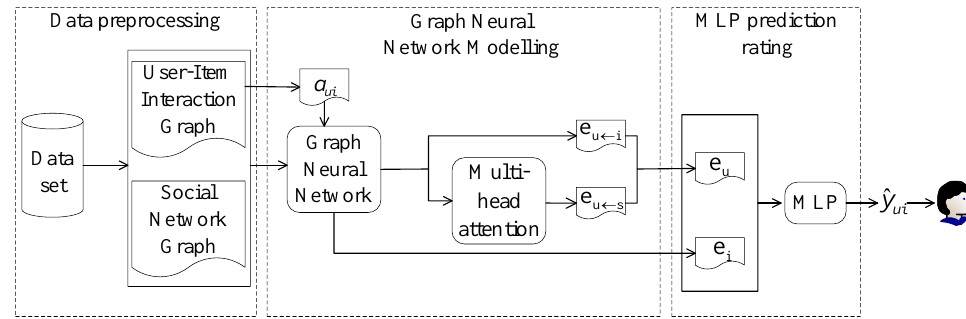
Figure 5. Framework of algorithm GNNSR_MAM.